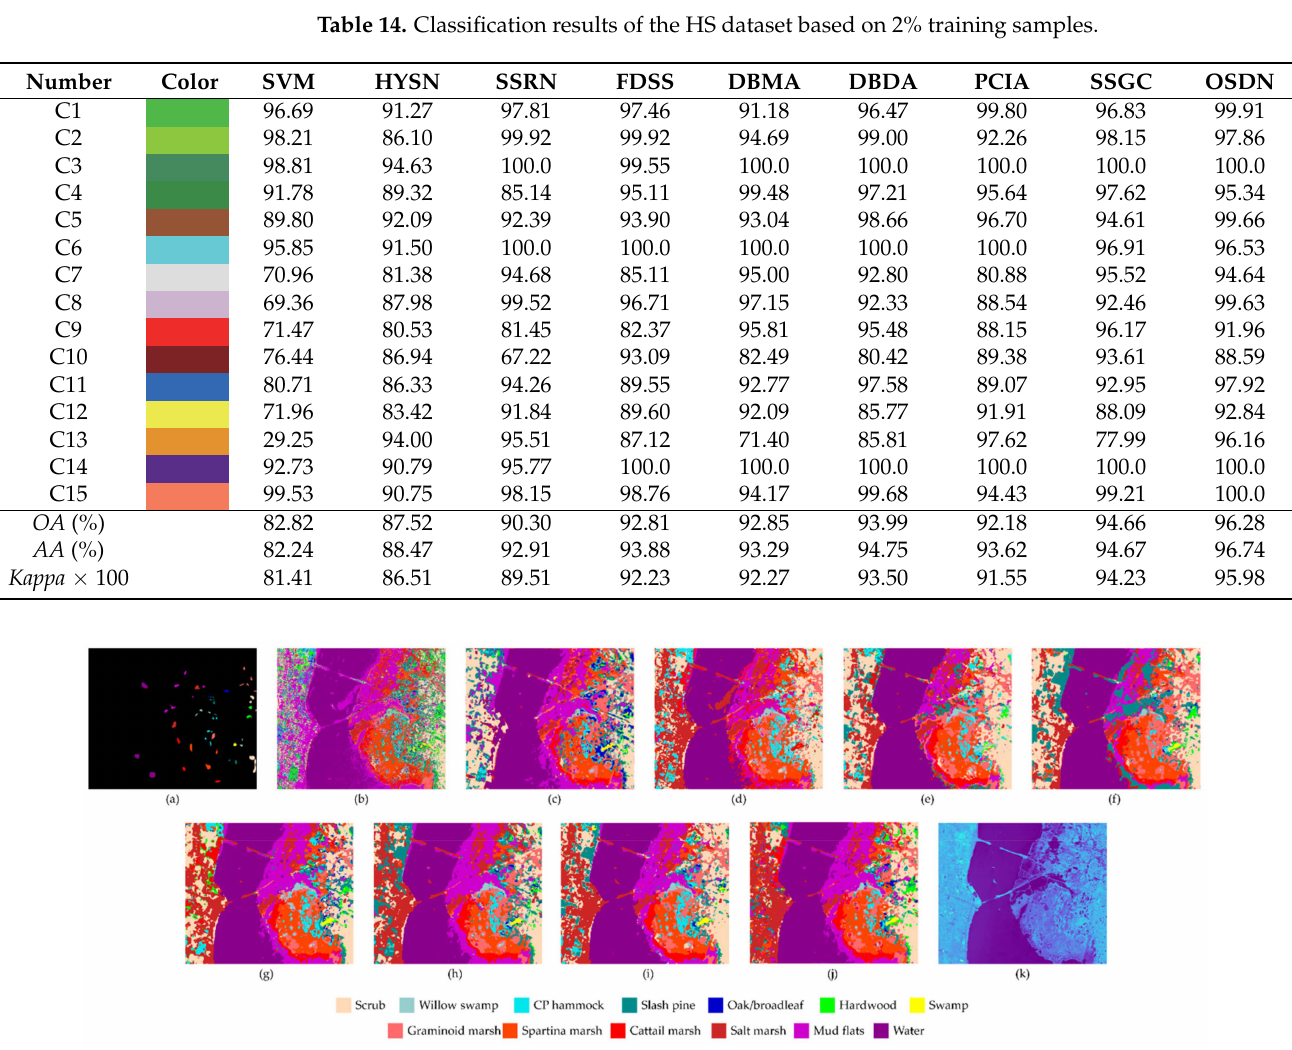
Figure 8. Full-factor classification maps for the KSC dataset. ( a ) Ground-truth. ( b ) SVM. ( c )